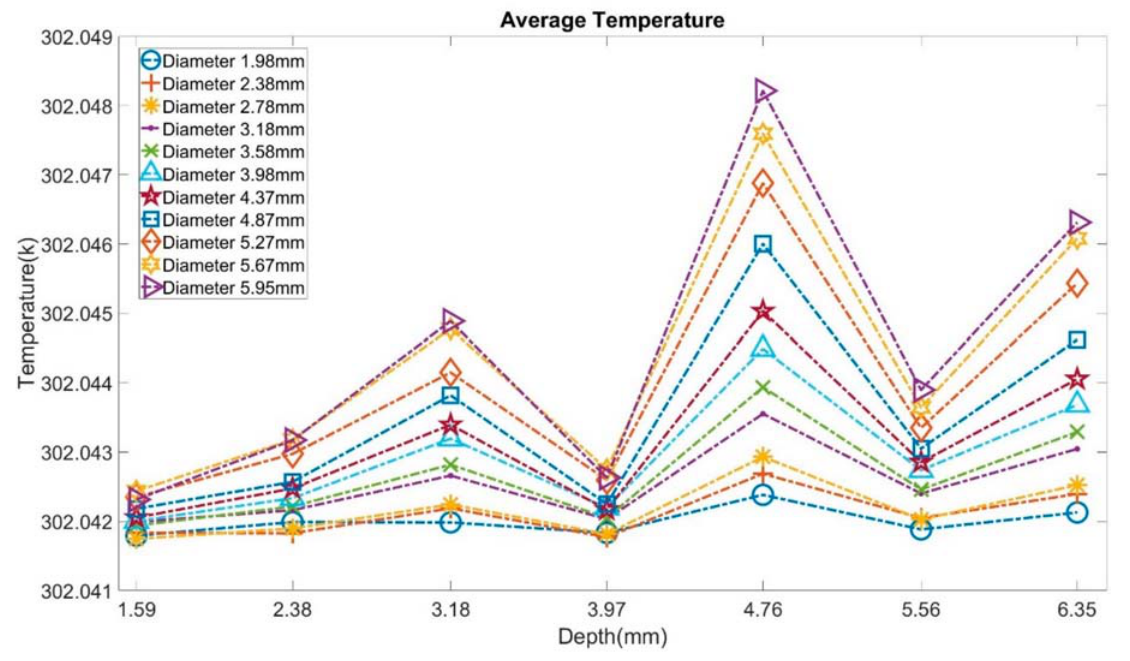
Figure 16. Average temperature through the cooling process from all